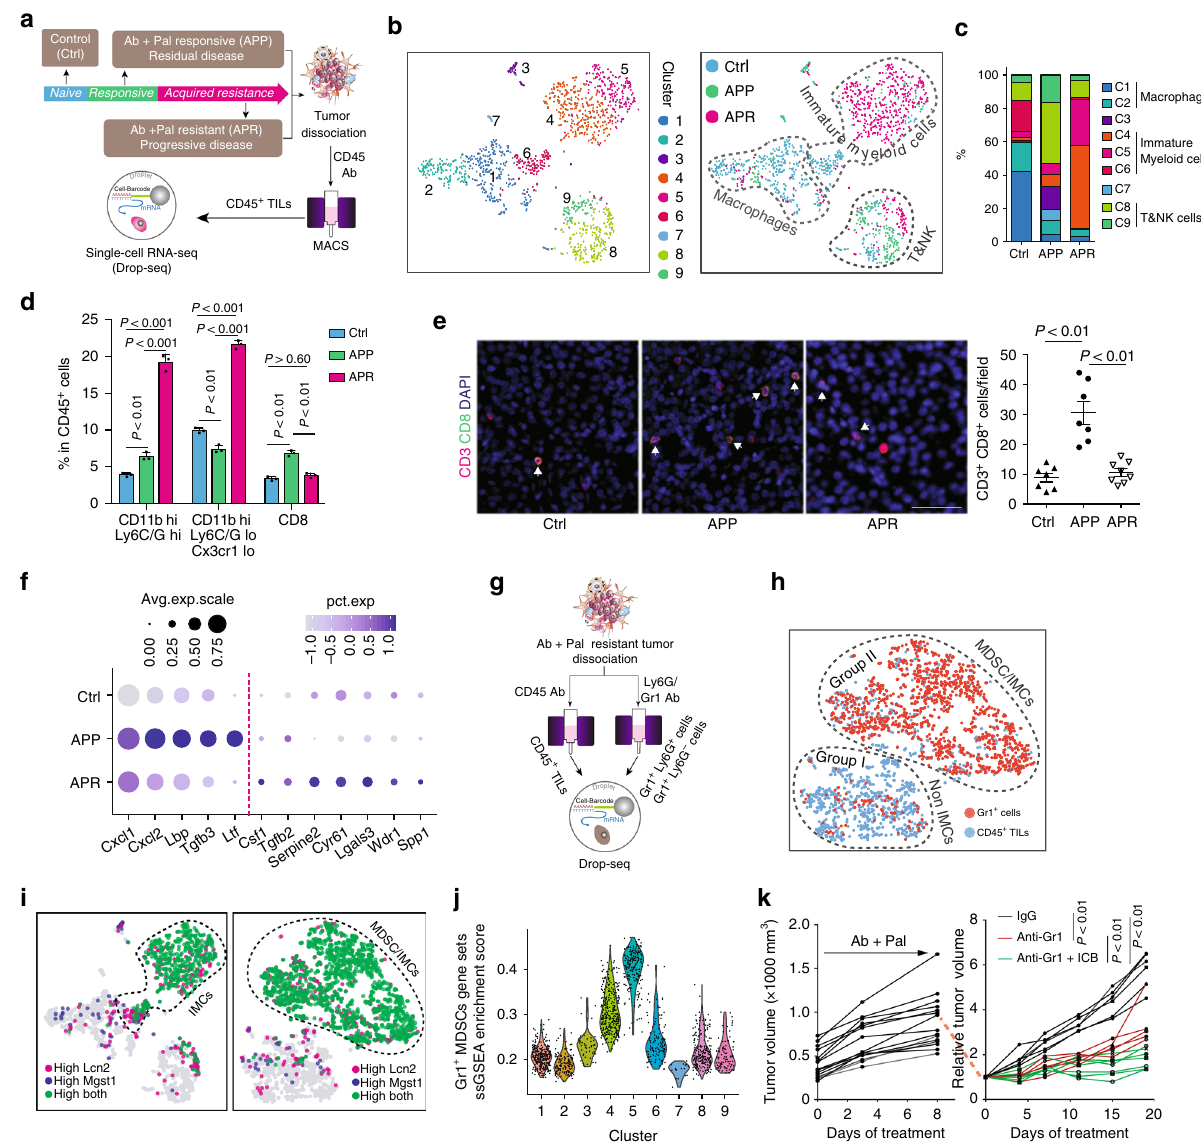
Fig. 2 Distinct immune milieu in different phenotypes and immature myeloid cells are enriched in resistant tumors. a Schematic for tumor dissociation, isolation of tumor in fi ltrated leukocytes and Drop-seq based scRNA sequencing. Ctrl, vehicle-treated control; Ab, anti-HER2/Neu antibody; Pal, CDK4/6 inhibitor Palbociclib; TILs, tumor in fi ltrated leukocytes. b Clustering of 1444 TILs derived from Ctrl, APP, and APR tumors and t-SNE plot colored by clusters (left) and annotation of TIL-clusters on t-SNE plot colored by treatment groups (right). c Abundance of each cluster (as clustered and annotated in b ) in TILs with indicated treatment. d Analysis of immune cell populations among CD45 + TILs by mass cytometry. e Representative images and quanti fi cation of CD3 and CD8 immuno fl uorescence staining for Ctrl, APP, and APR tumors. Arrows indicate CD3 and CD8 double-positive cells. Scale bar, 50 μ m. f Single- cell transcriptional analysis of tumor-produced cytokines and chemokines. The size of each circle re fl ects the percentage of cells in a treatment group where the gene is detected, and the color intensity re fl ects the average expression level within each treatment group. g Schematic for tumor dissociation, isolation of CD45 + TILs and Gr1 + cells and scRNA-seq. h t-SNE plot of scRNA-seq data containing 1153 CD45 + TILs and 1318 Gr1 + cells. i Overlay of marker genes for Gr1 + cell population identi fi ed from experiment of g on t-SNE plots derived from b and g , respectively. j Violin plot showing distribution of ssGSEA enrichment score among TIL-clusters identi fi ed from b . MDSCs signature generated by experiment as shown in g was used for enrichment analysis. k Growth of APR tumors by adding Gr1 antibody and ICB. APR tumors were transplanted to recipient MMTV-neu mice and treated with Ab + Pal fi rst to acquire the resistance phenotype (left) and then adding IgG ( n = 6), anti-Gr1 ( n = 5) or anti-Gr1 + ICB ( n = 7) treatments were followed (right). Each point represents a single cell in b , h , i , j . Error bars represent SD in d and SEM in e . P -value in d , e , k by one-way ANOVA with Tukey ’ s indicated a distinct immune milieu among control, Ab + Pal TILs of control, APP, and APR tumors using CyTOF. CD45 + live responsive and resistant tumors. The responsive tumors con- cells were analyzed and we observed an increase of CD11b high myeloid cells while a decrease of CD11b low cells in APR tumors, tained a higher frequency of T and NK cells while the resistant and more T and NK cells in APP tumors (Supplementary tumors were dominated by IMCs (Fig. 2c). Fig. 5A – C), which was consistent with the trend of scRNA-seq To connect the canonical cell surface markers with the pro fi ling and classi fi cation. Lymphocyte antigen 6 complex observed transcriptome heterogeneity of TILs, we pro fi led the